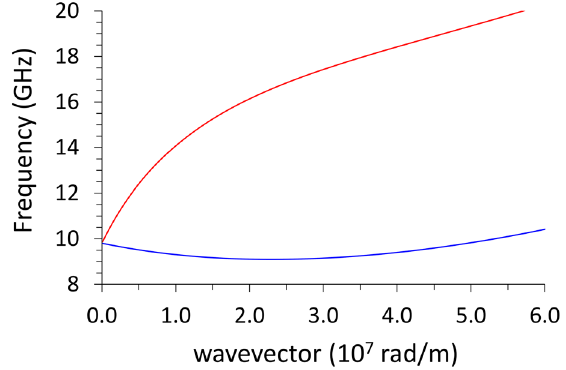
Figure 3. Dispersion relation for a 30-nm thick infinite film: upper curve (red) refers to the surface Damon- Eshbach mode; the lower curve (blue) refers to the volume backward mode. The magnetic parameters are the same used in the simulations.